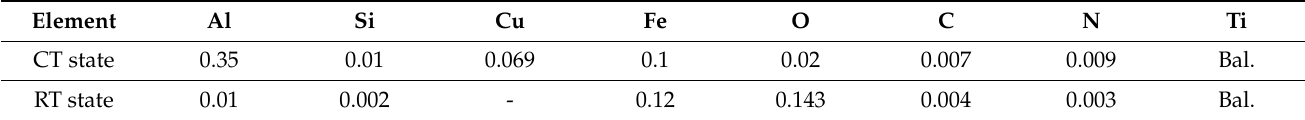
Table 1. Chemical composition in wt.% of investigated states of titanium